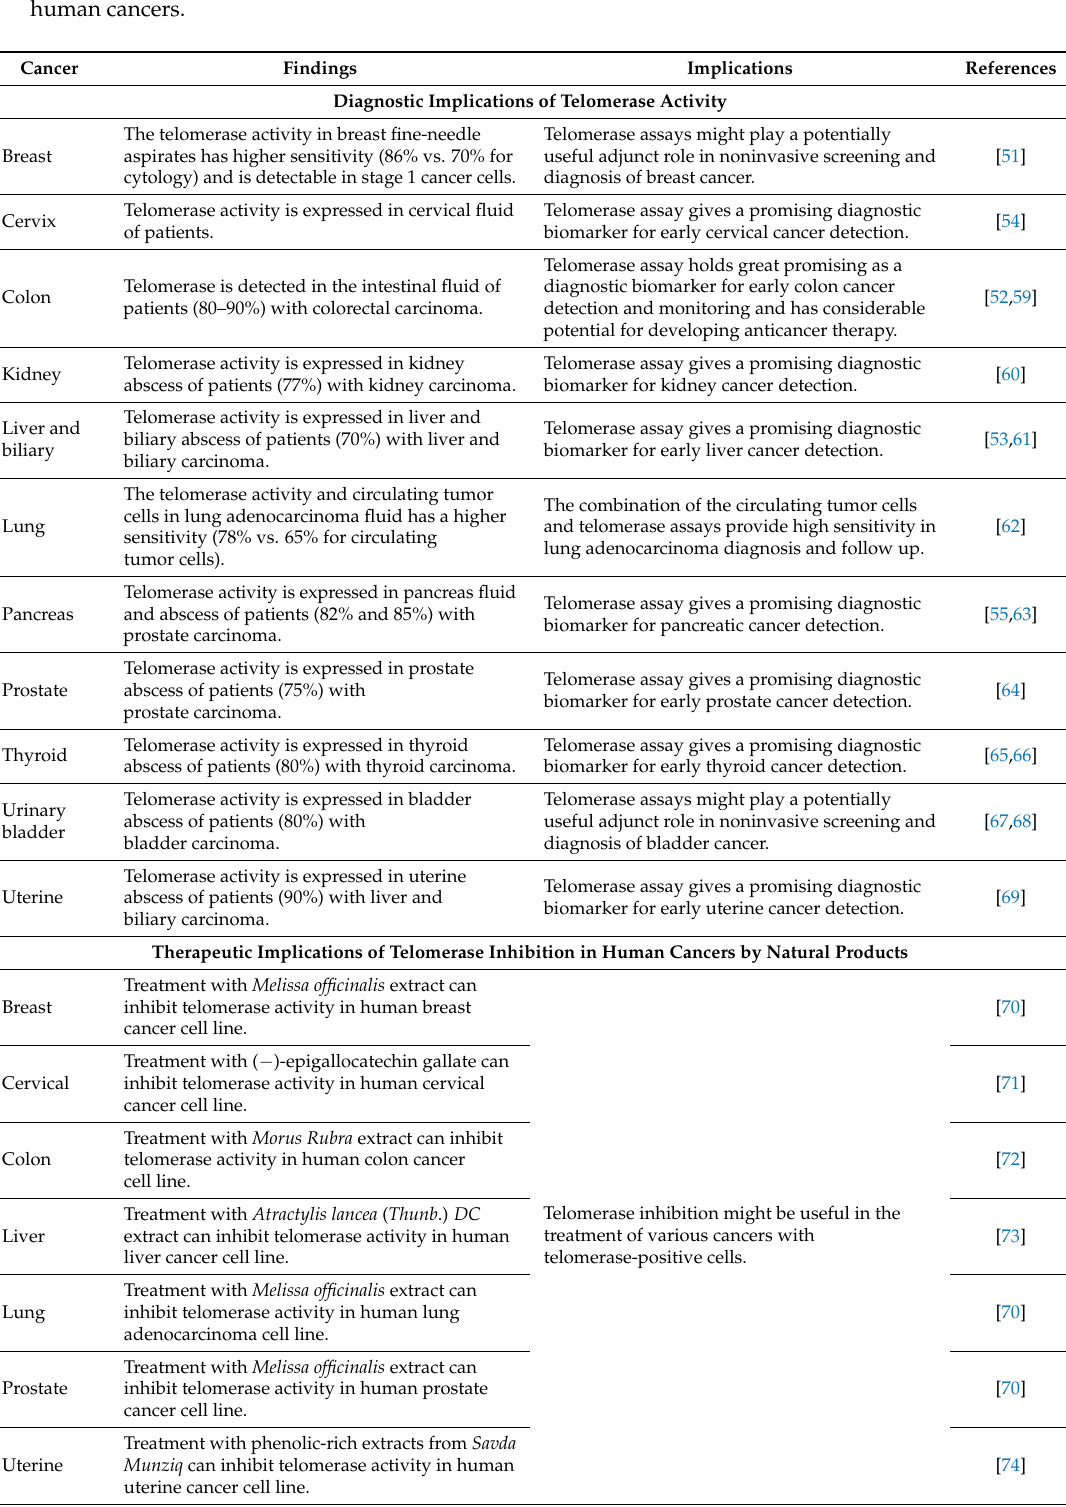
Table 2. Diagnostic and therapeutic implications of telomerase and telomerase inhibition on various human